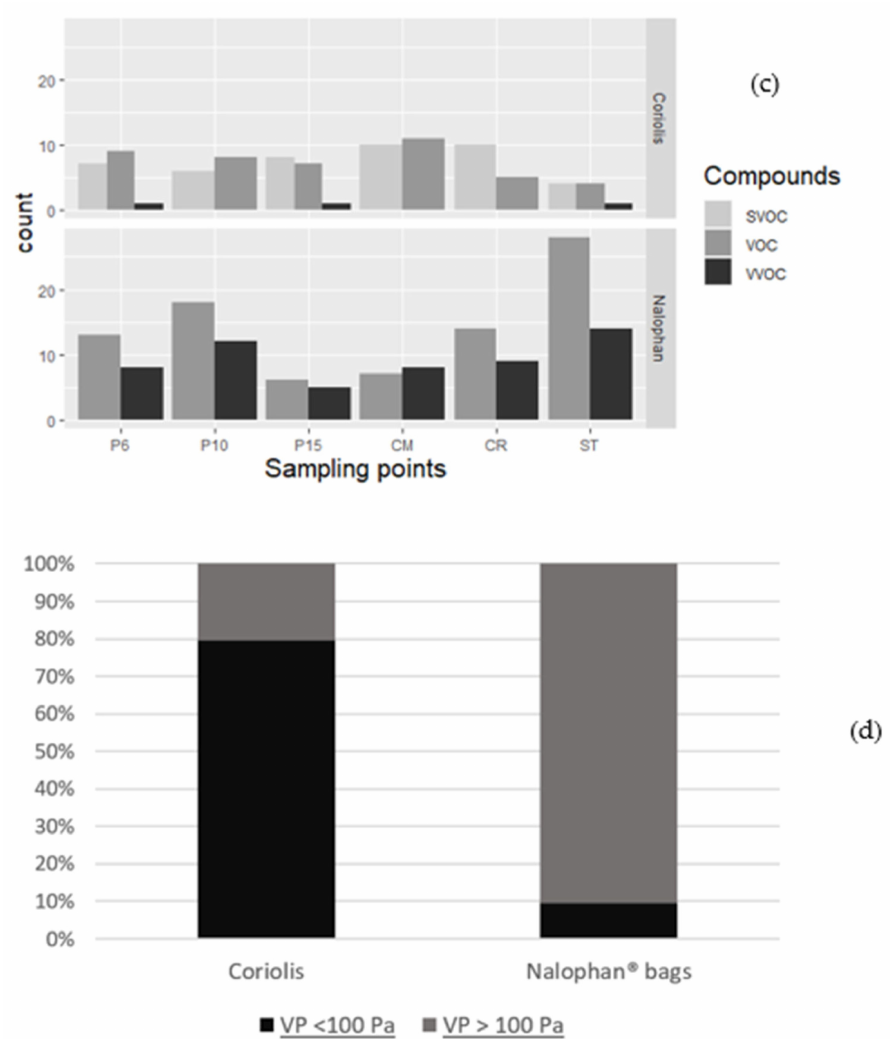
Figure 4. ( a ) The octanol/air partition coefficient repartition according to the method used. Log K oa of molecules obtained with Coriolis micro are significantly different from those obtained with Nalophan ® bags ( p -value < 0.01, Supplementary Materials: Table S3); ( b ) box plot of the log-transformed Henry’s constant in Pa.m 3 /mol molecules according to the methods used. Henry’s constants are not sig- nificantly different between those of Coriolis micro and those of Nalophan ® bags except for P6 ( p -value < 0.01); ( c ) repartition of boiling points (BP) according to the method use. Figure represents BP comprised between 260 ◦ C and 400 ◦ C for semi volatile organic compound (SVOC); BP comprised between 100 ◦ C and 260 ◦ C for volatile organic compound (VOC) and BP below 100 ◦ C for very volatile organic compound (VVOC), no significant differences were found; ( d ) vapor pressure supe- rior and inferior to 100 Pa to determine volatility of each compound found with both techniques, no significant differences were found. Black dott represents an outlier value of the boxplot; ** mean p value <